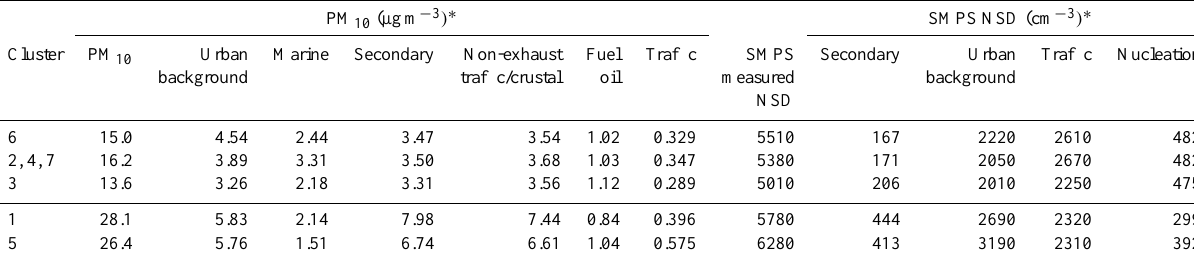
Table 5. Average daily contribution from each factor for each trajectory